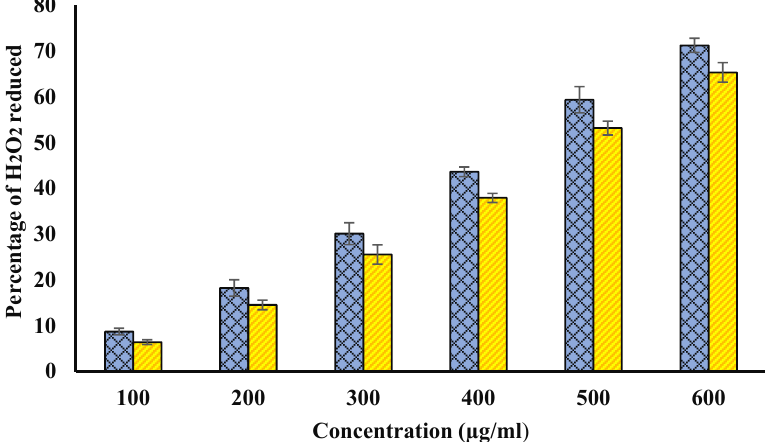
Figure 2. Percentage of H 2 O 2 scavenging potential of methanol extracts of Ajwa fruit pulp (blue) and seed (yellow). Samples at y-axis show various concentrations of extracts (100, 200, 300, 400, 500, and 600 µg/mL). The results are presented as means ± SEM ( n = 3, p < 0.05).